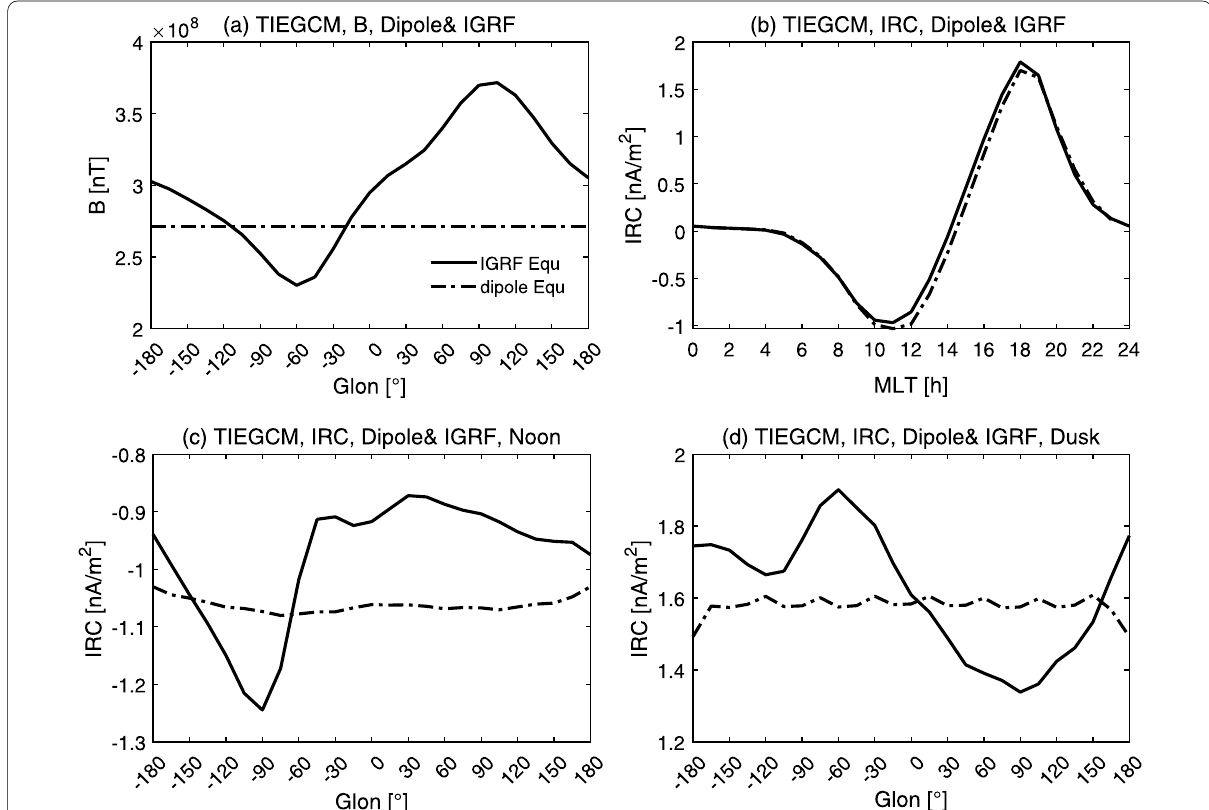
Fig. 6 Longitudinal variations of a northward component of magnetic field and c , d IRC in equinox under two different geomagnetic field configurations: IGRF and dipole cases. b MLT variations of IRC in IGRF and dipole cases in equinox. IRC is the longitudinal averaged value. Positive values in a represent the northward magnetic field. The solid and dotted lines represent IGRF and dipole